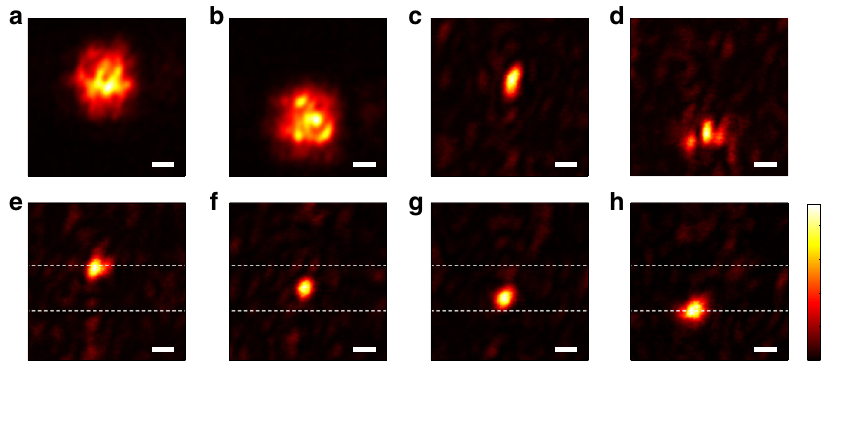
Fig. 4 Experimental focal scan using two acousto-optic transmissiom matrices: Measured intensity distributions at the ultrasound focal plane for: a , b acoustically-tagged light by each of the two ultrasound foci, averaged over 50 random input fi elds. c , d Focusing via SVD of T 1 ( c ) or T 2 ( d ) independently, as in Figs. 1 – 2, with corresponding peak to background ratio (PBR) of 102 ( c ) and 83 ( d ). e – h Injecting the fi rst singular vector of the matrix A α (Equation 3), with α values of 0.05 ( e ), 0.1 ( f ), 1 ( g ), and 10 ( h ), demonstrating the ability to scan a tight optical focal spot between the two ultrasound foci. The corresponding PBRs are 80, 97, 100, and 67 for e , f , g , h correspondingly. scale-bars, 90 μ m